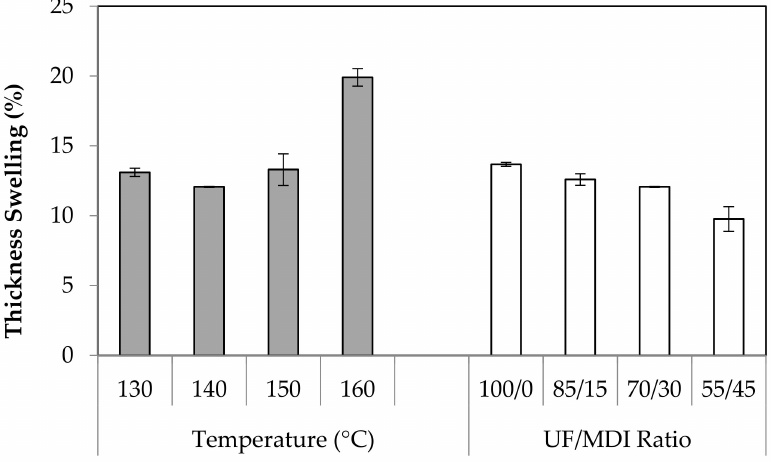
Figure 6. Thickness swelling of the particleboard. The bars indicate the standard